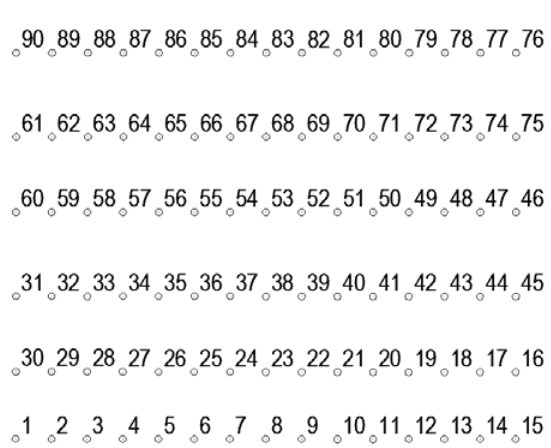
Figure 2. Calibration test